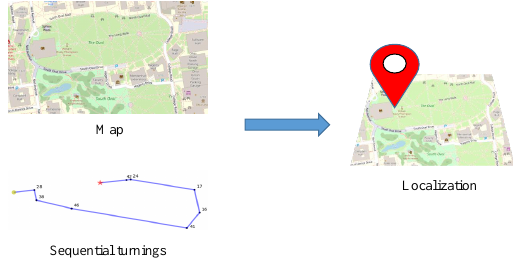
Figure 1. The concept of localization using a map and a trajectory. The motion generating the observed trajectory can only have one matching location if the shape of the trajectory is unique and matches the map road network. A trajectory can be unique if it is long enough (the map shown is from